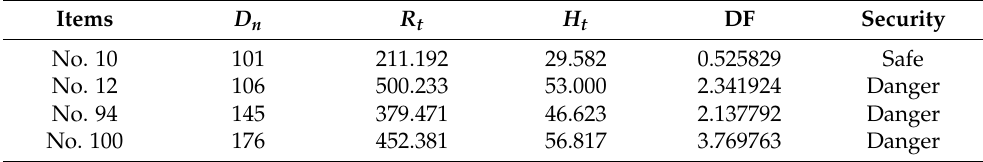
Table 1. Dangerous gap evaluation